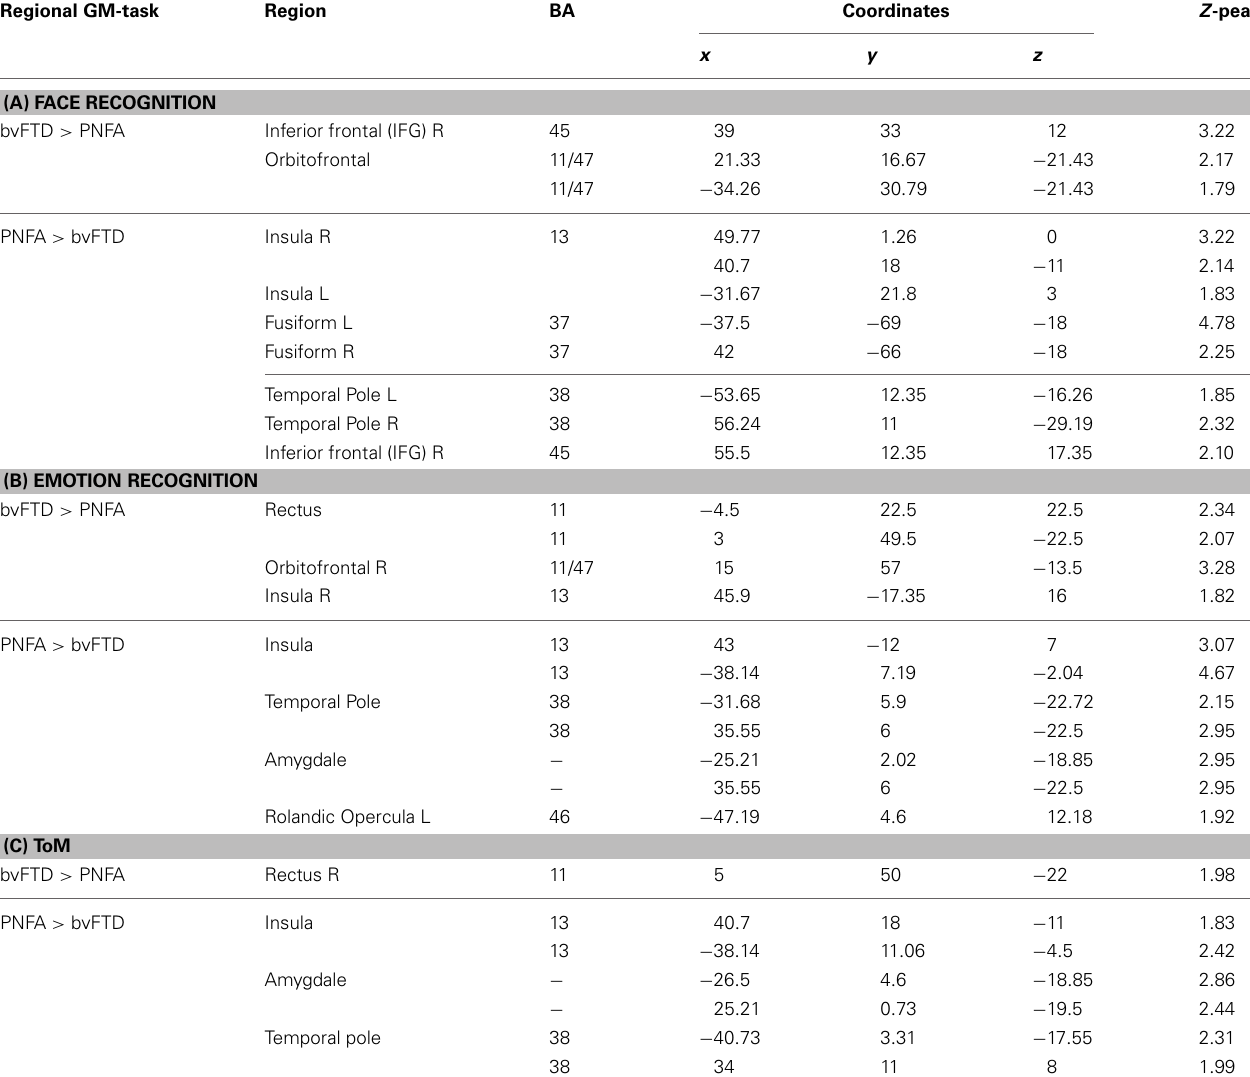
Table 4 | Patterns of trophy correlated with task performance in bvFTD and PNFA. Regional GM-task Region BA Coordinates Z -peak x y z